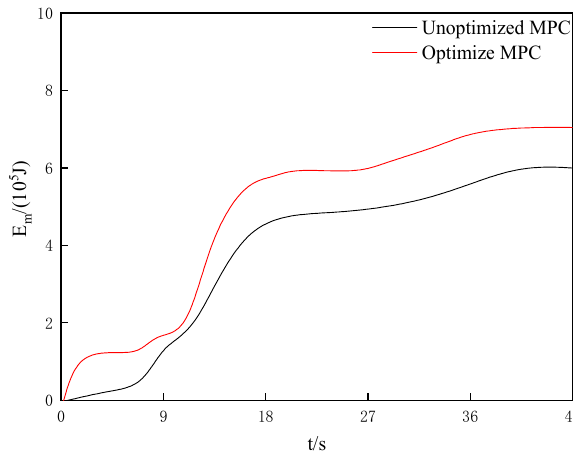
Figure 6. Simulation results of energy recovery.